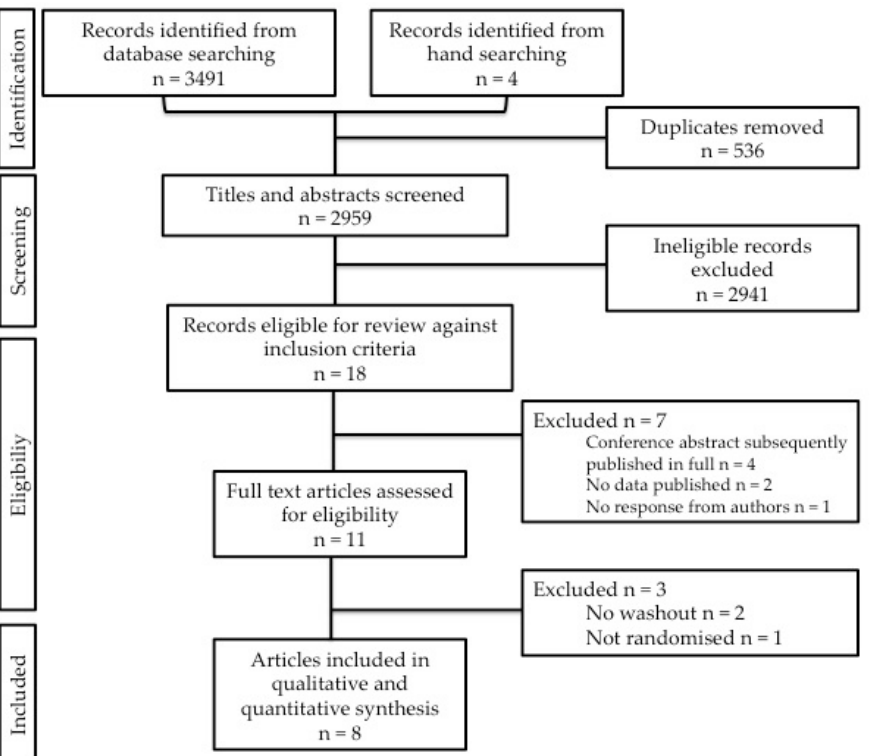
Figure 1. PRISMA flow diagram of studies in systematic review. PRISMA, Preferred Reporting Items for Systematic Reviews and Meta-Analyses.